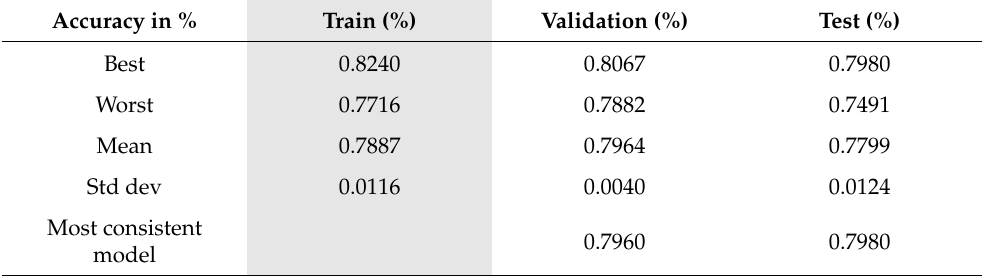
Table 4. Summary table for Approach A4—Random accuracy (in %).